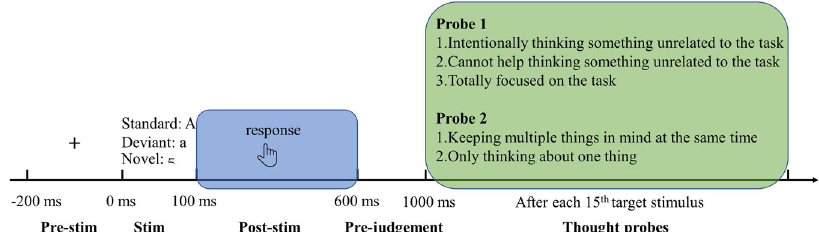
Fig. 1 Experiment process and analysis schema. Experiment process: Each participant performed 1800 Sustained Attention to Response Task (SART) trials. In each trial, three types of stimuli were presented randomly for 100 ms after 200 ms fi xation period: standard stimulus (upper case English letters), target stimulus (lower case English letters) and novel stimulus (letters from minority languages). Participants were requested to respond to the target stimuli by pressing the F key on the keyboard during the 900 ms blank window following stimulus (post-stimulus period). After each 15th target stimulus two thought probes were shown, participants were asked to answer the probe questions based on their types of thoughts (on- vs off-task and single vs multiple